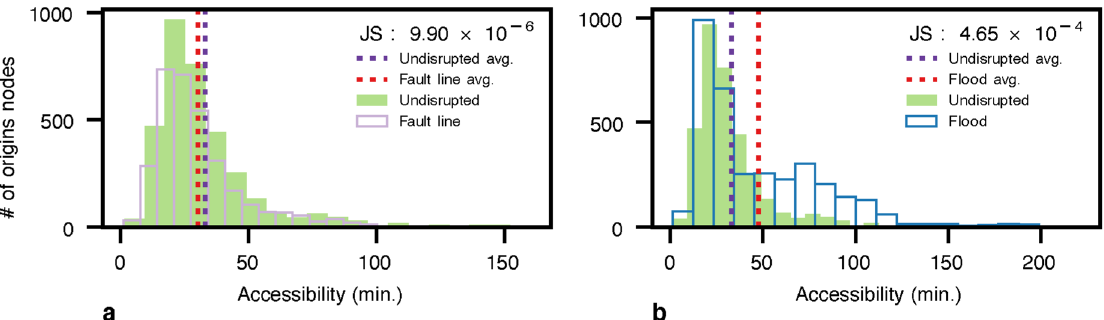
Figure 4. Accessibility time distribution to all reachable healthcare facilities in Lima city. Where ( a ) is the baseline and fault line scenario with a buffer of 500 m with a return period of 50 and 100 years; and ( b ) is the baseline and flood scenario of flood planning hazard map at historical return period. Flood in (b) illustrates a significant change in the accessibility time distribution concerning fault lines in ( a ). However, the number of accessible facilities reduces in ( a ) and the population’s healthcare facility priority list change. The Jensen- 6 4 Shannon divergence are 9.9 × 10 − and 4.65 × 10 − for (a) and (b) concerning the undisrupted (baseline)